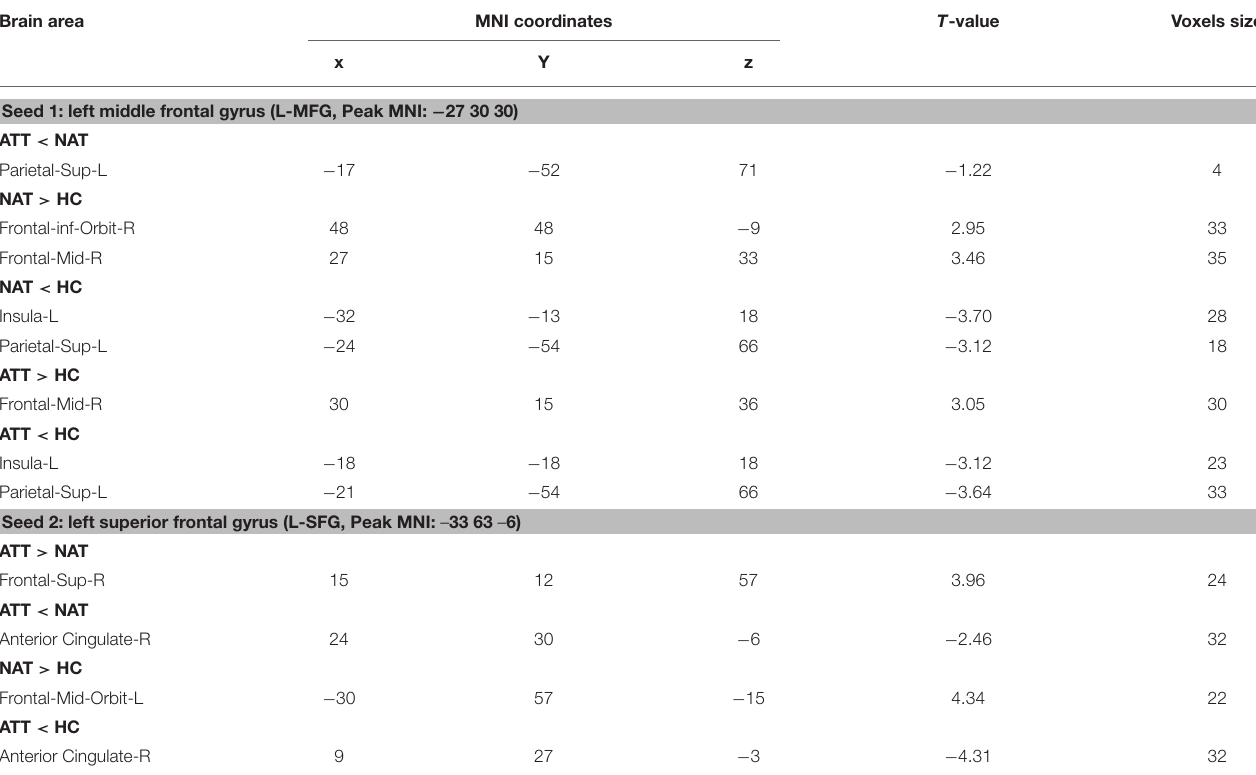
TABLE 2 | Differences in left MFG and SFG seed functional connectivity among the ATT group, NAT group, and HC group. Brain area MNI coordinates T